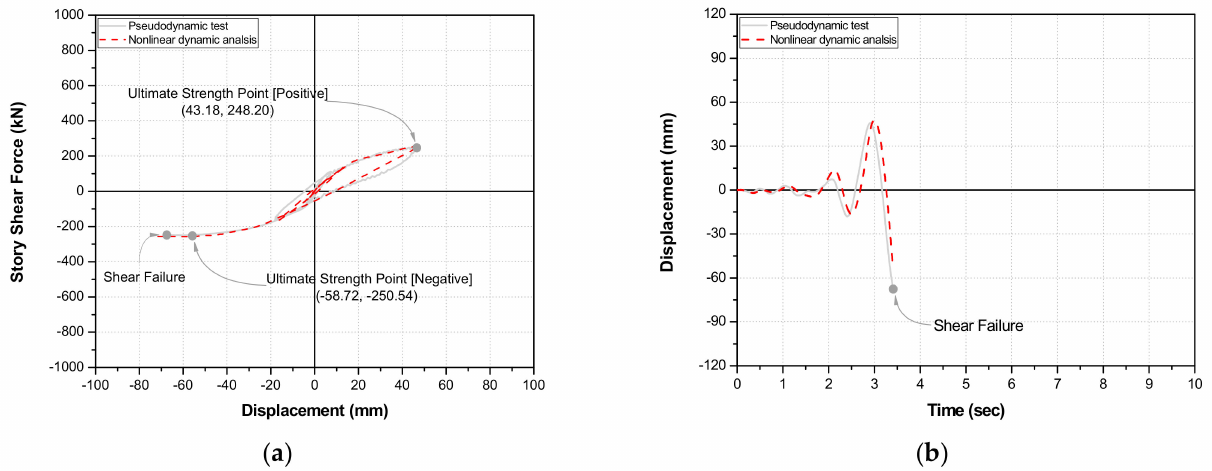
Figure 21. Comparison of non-linear dynamic analysis and pseudo-dynamic test results of RC frame with no reinforcement applied (PD-FR) (first floor, 200 cm/s 2 ): ( a ) load-displacement curves; ( b ) displacement-time hysteresis